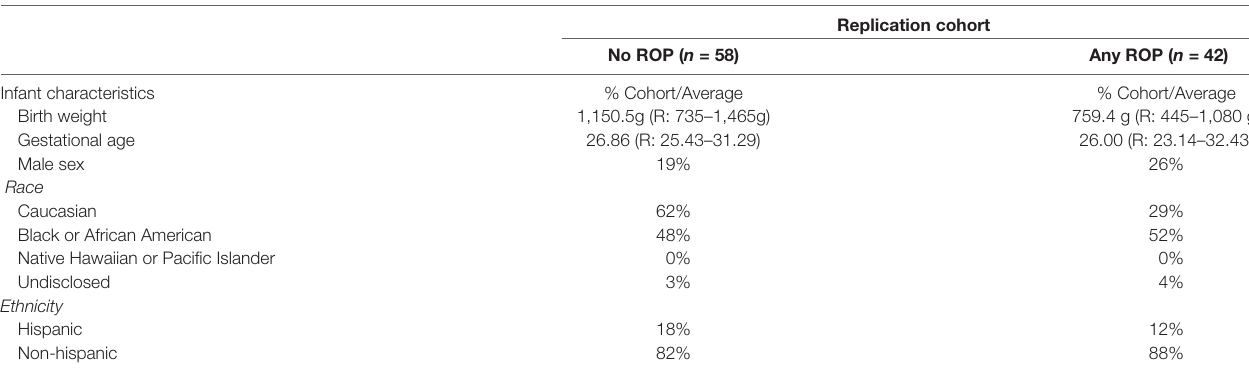
TABLE 4 | Replication cohort clinical characteristics.